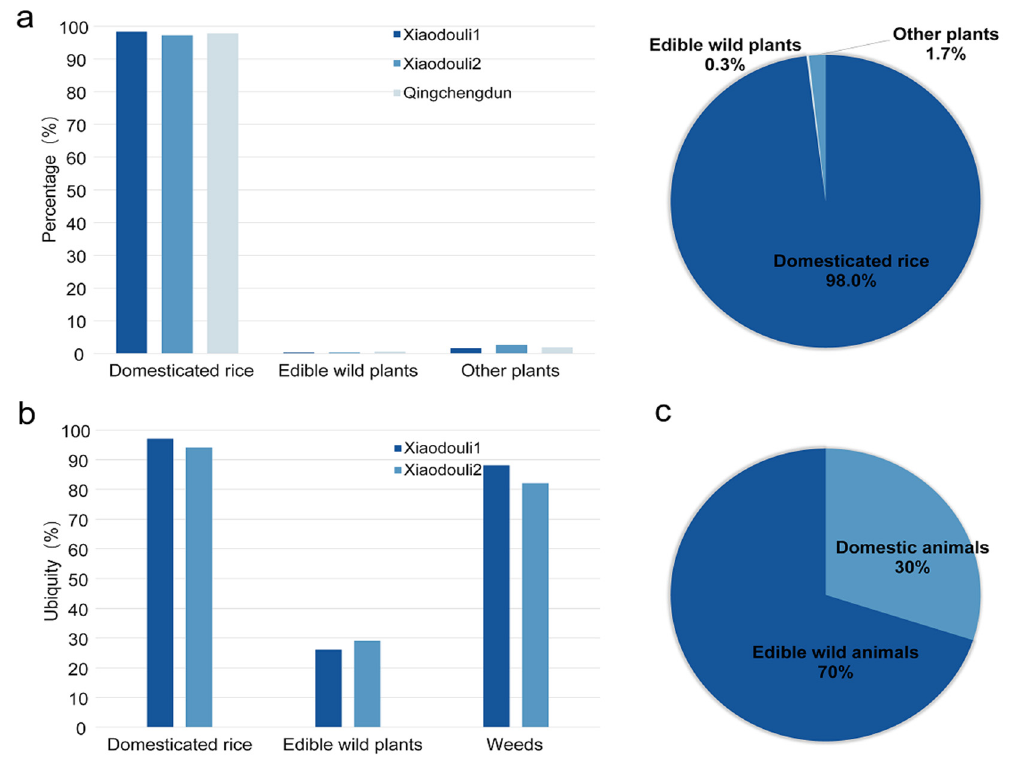
Figure 4. Comparison of different food resources during the Songze Cultural period. Percentages ( left ) and relative proportions ( right ) of the three plant groups from the two sites ( a ); Ubiquity of the three plant groups from the Xiaodouli site ( b ); relative proportions of domestic animals and edible wild animals at the Songze site ( c ). Xiaodouli1 and Xiaodouli2 in this figure indicate two sets of independent archaeobotanical data from the same site which can be seen in Table S1(II,IV).